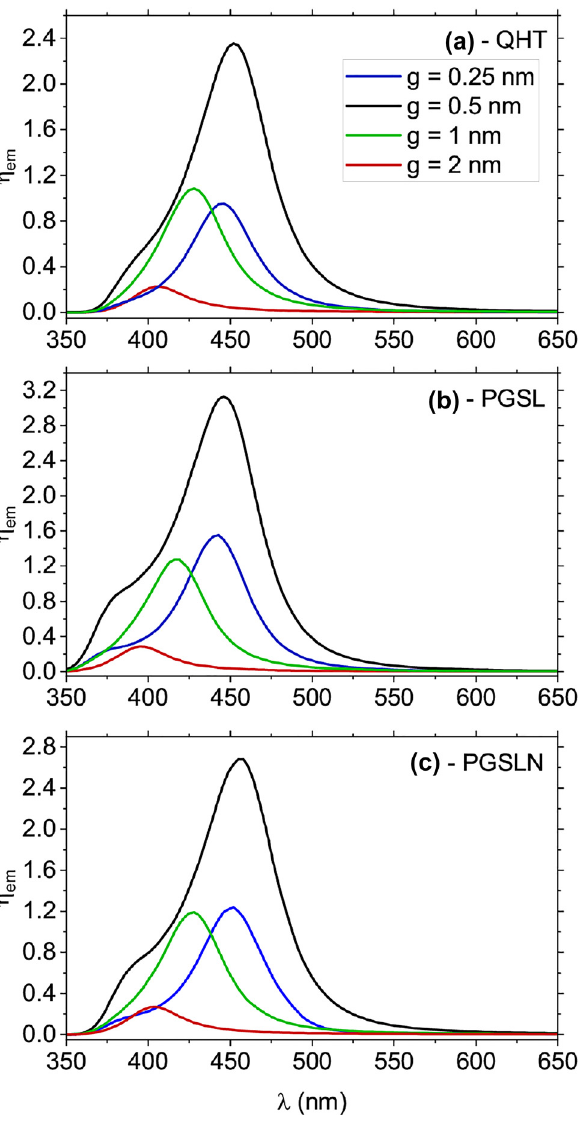
Figure 6: The dependence of fluorescence enhancement on the wavelength for different gap values as calculated from the QHT, PGSL and PGSLN. The radius of spheres is R = 2 . 5